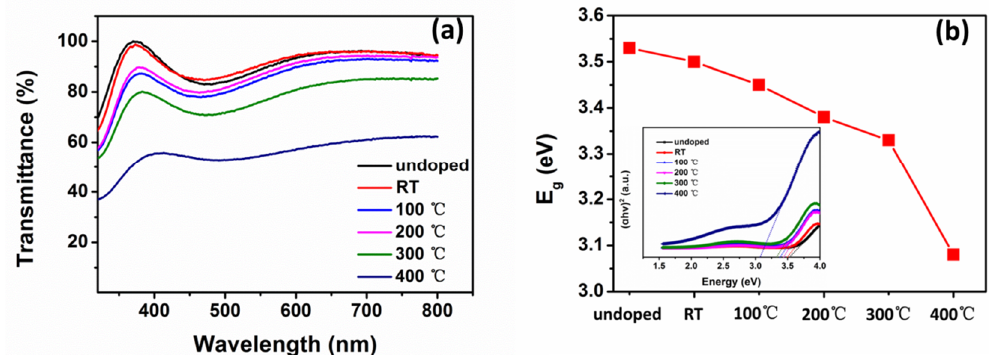
Figure 8. ( a ) UV–Vis transmittance spectra and ( b ) optical bandgap energy of NiO thin films deposited at different substrate temperatures.